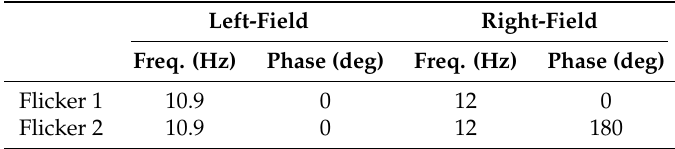
Table 1. The parameters of two phase-tagged half-field flickers.